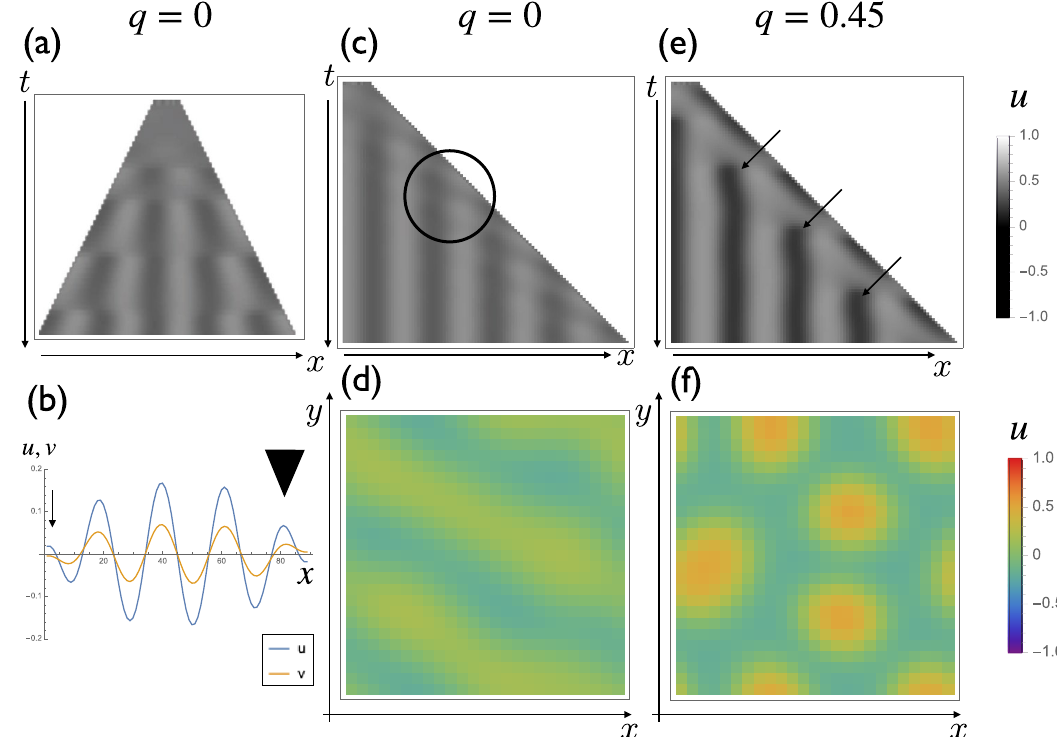
Figure 2. The mode doubling pattern in one dimensional simulations and stripe- spot selection in two dimensional simulations. ( a ) Pattern formation with a uniform domain growth with zero flux boundary conditions. The parameter set we used was: f u = 0.6, f v = − 1, g u = 1.5, g v = − 2, d u = 0.0002, d v = 0.002, c = 1, q = 0 . We could observe the formation of new peaks restricted to the boundary. ( b ) The distribution of u (blue) and v (orange) at the timepoint of new peak formation. Splitting (arrowhead) and insertion (arrow) are observed simultaneously. ( c ) Pattern formation when growth is restricted to the right edge and the reaction term is symmetric ( q = 0 . Detailed explanations of q is in “Materials and methods” section). A new peak is always generated at the site of growth. It is not clear whether splitting or insertion occurs (circle). ( d ) Two dimensional pattern formation of the system ( q = 0). The stripe pattern is formed. ( e ) Pattern formation with a nonzero q term ( q = 0.45) when growth is restricted to the right edge. Insertion becomes predominant (arrows). ( f ) 2D pattern formation of the system with a nonzero q term ( q = 0.45). The spot pattern is